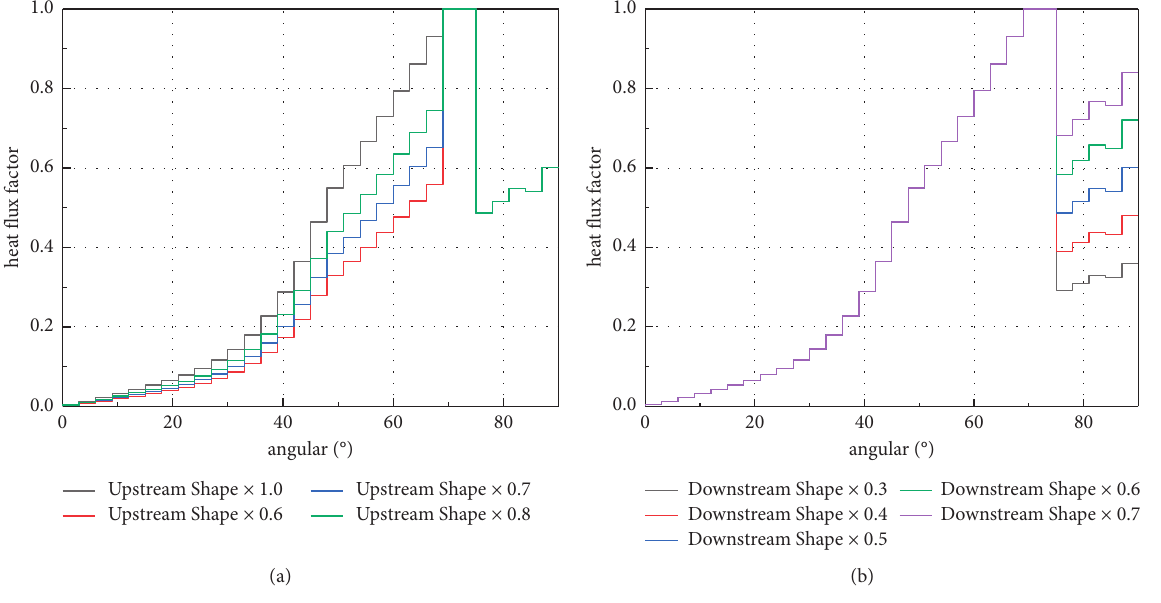
Figure 6: Heat flux distributions of (a) test case 2 and (b) test case 3.